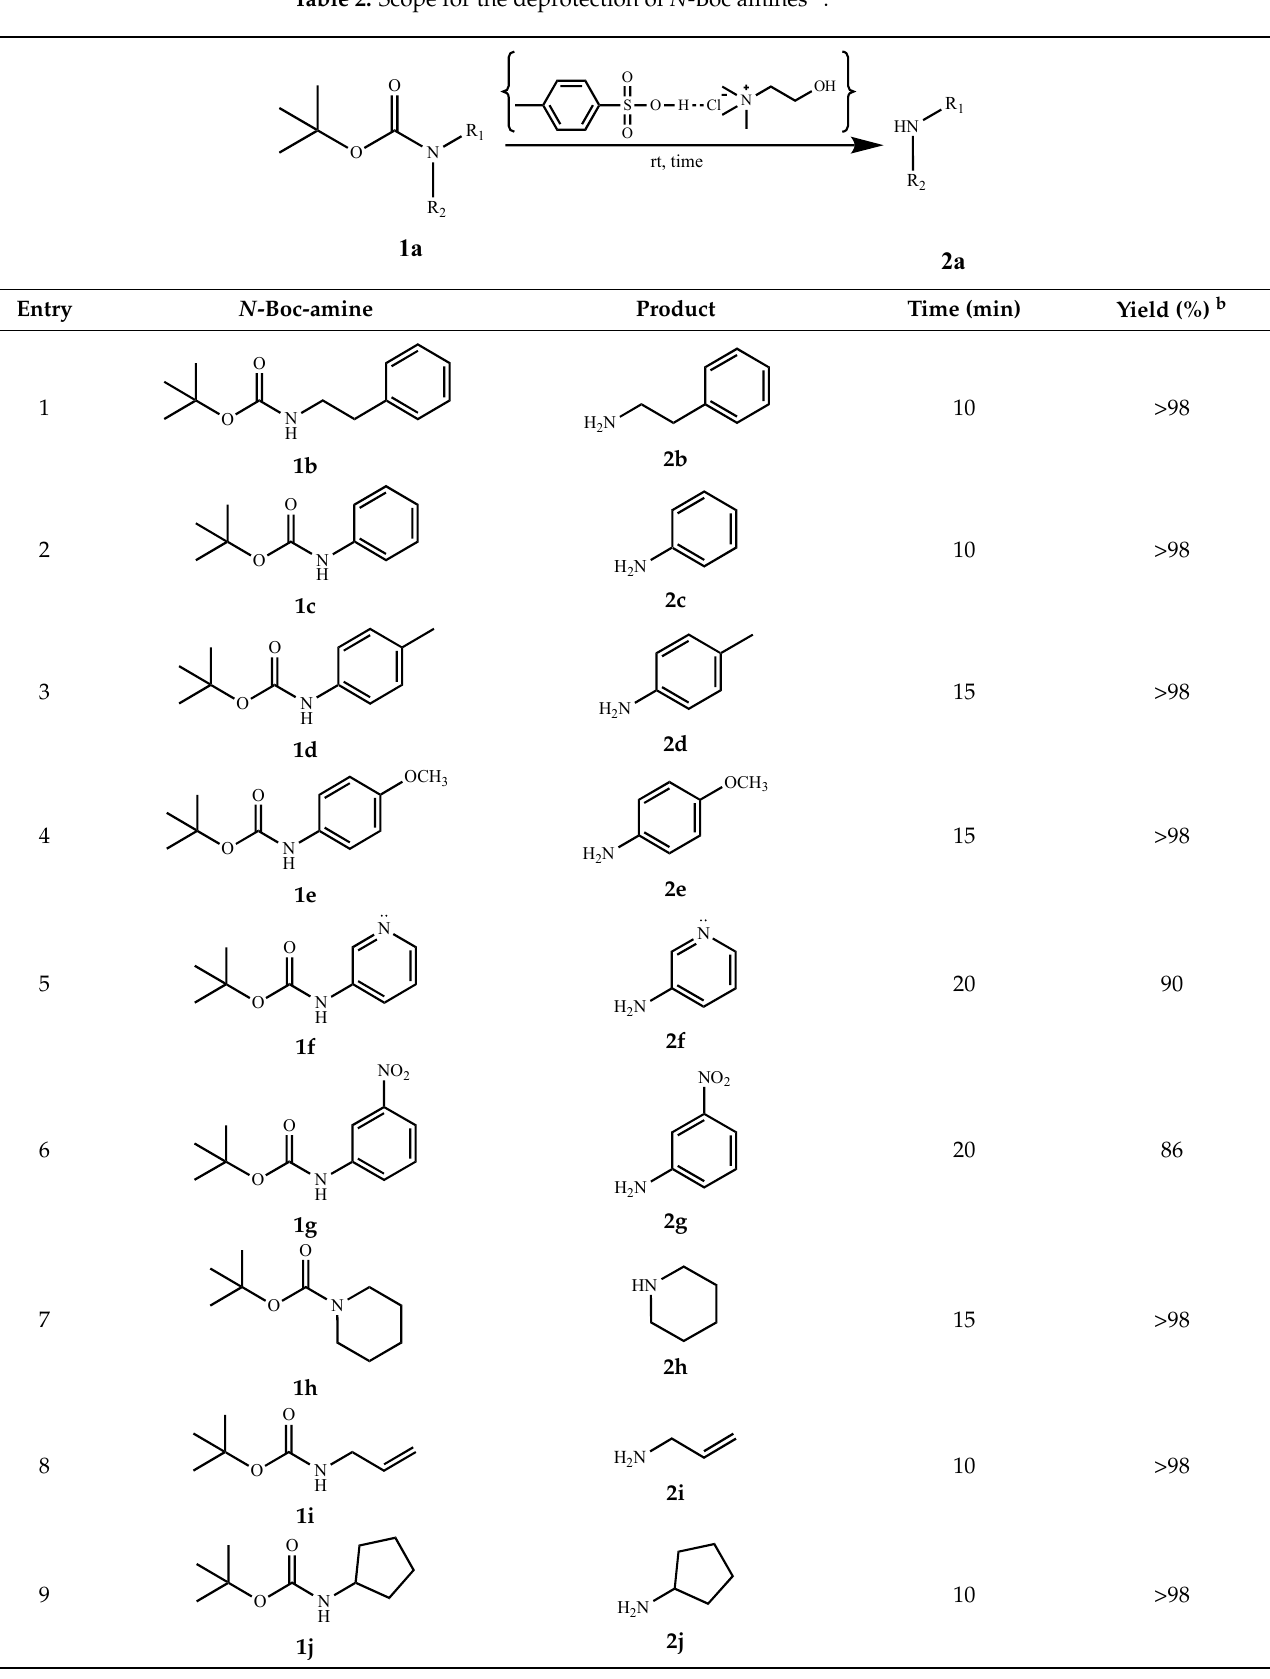
Table 2. Scope for the deprotection of N -Boc amines a .